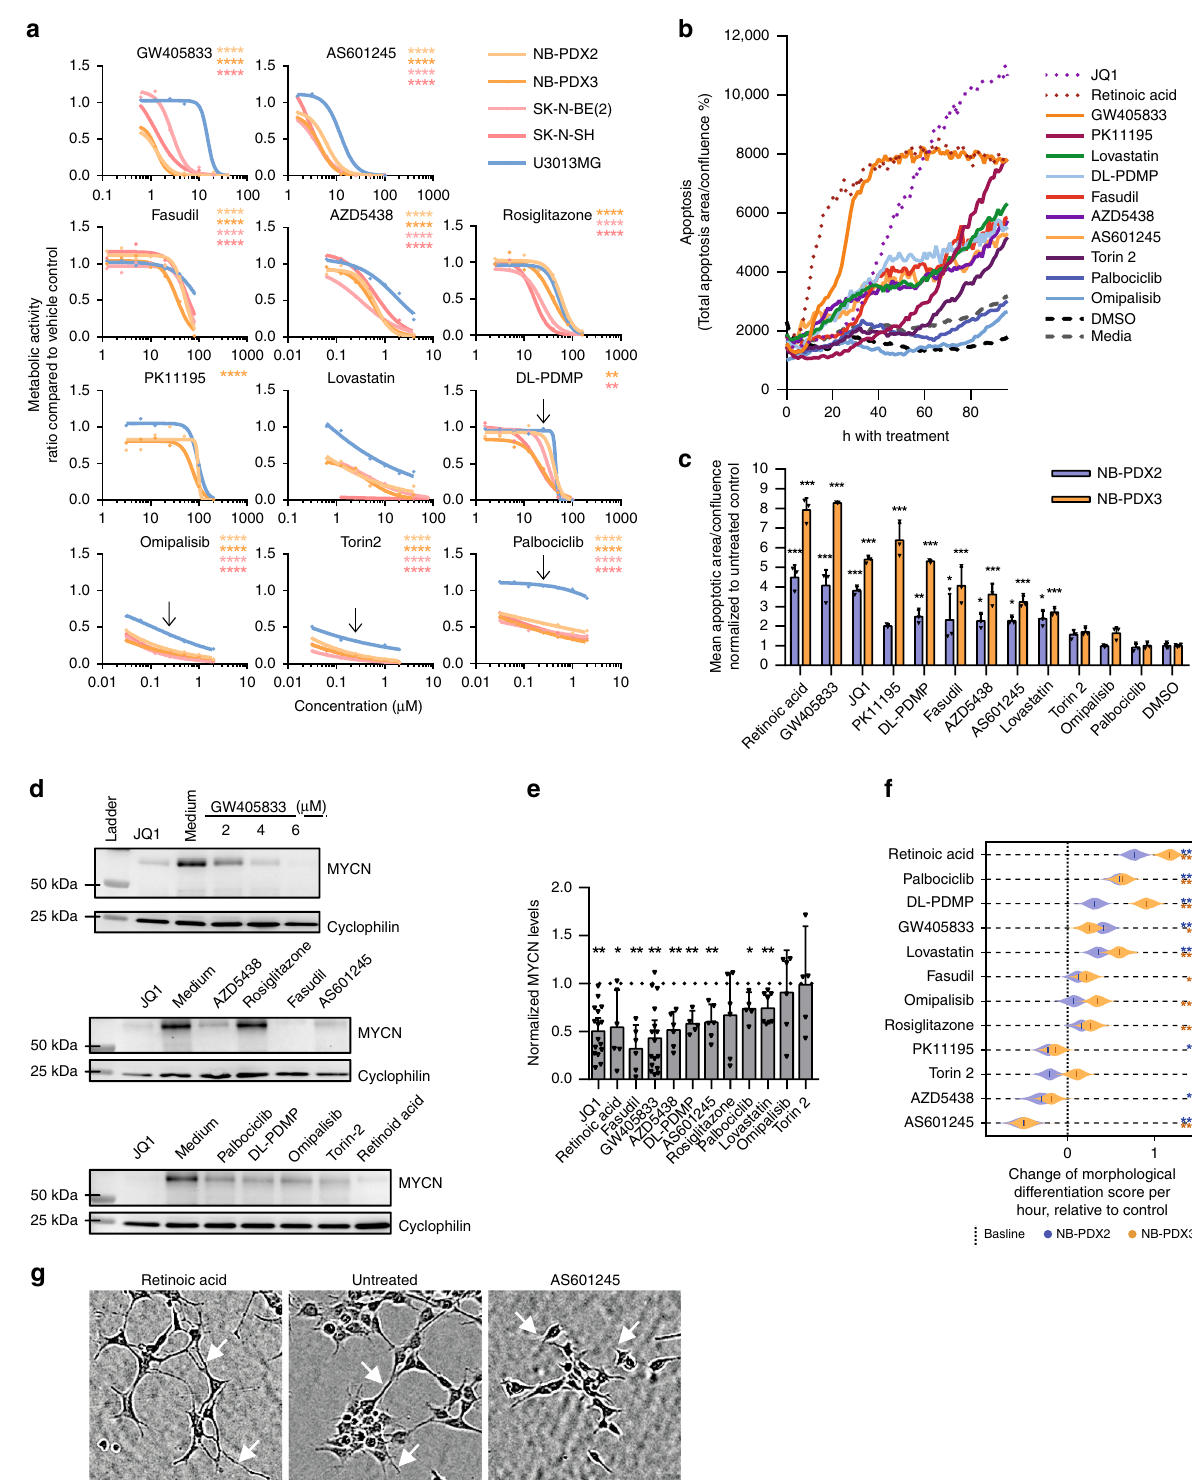
930 42 , which lacked effect even at high doses (Supplementary Fig. 4E, F). The three compounds with anti-neuroblastoma effect (AS601245, JNK-IN-8 and SP600125) have higher af fi nity for MAPK8 than at least one of the other isoforms, while CC-930 has a 12-fold lower af fi nity for MAPK8 than the other isoforms (Supplementary Fig. 4F). As a complementary analysis based on genetic methods, we considered a public data set of RNA interference data from the Broad institute DepMap 43 , in